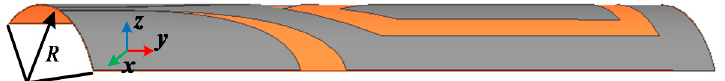
Figure 7. The wearable antenna prototype bent along the y -axis.